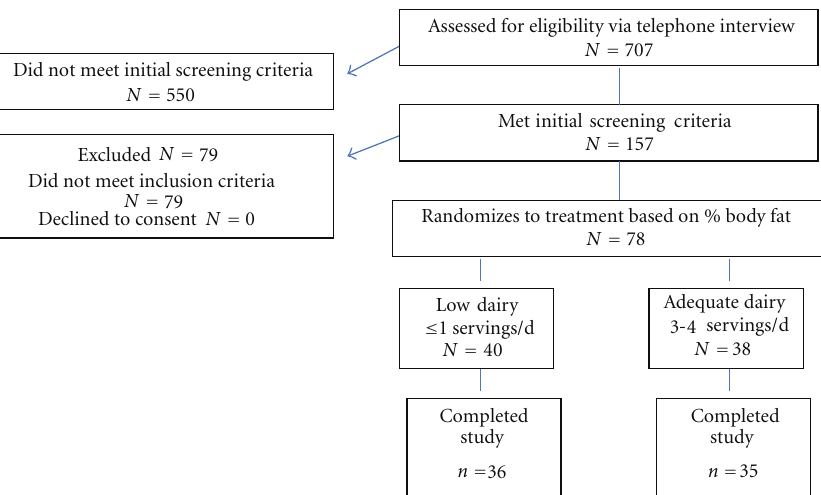
Figure 2: Consort diagram. Six individuals withdrew from the study prior to protocol completion and were excluded from data analysis.